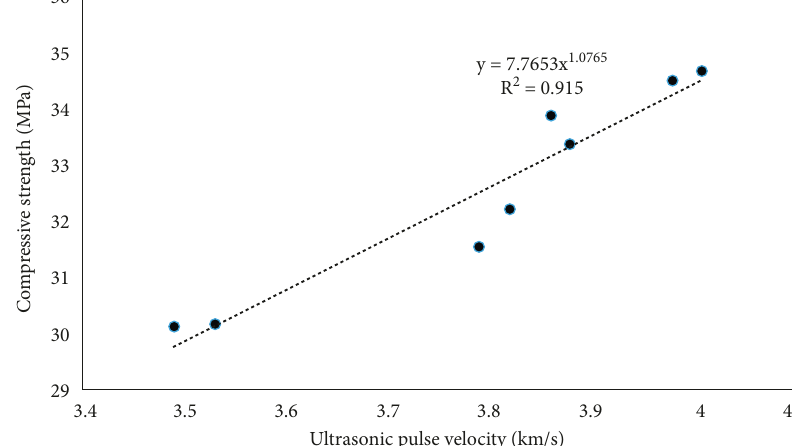
Figure 22: Comparison between compressive strength and UPV